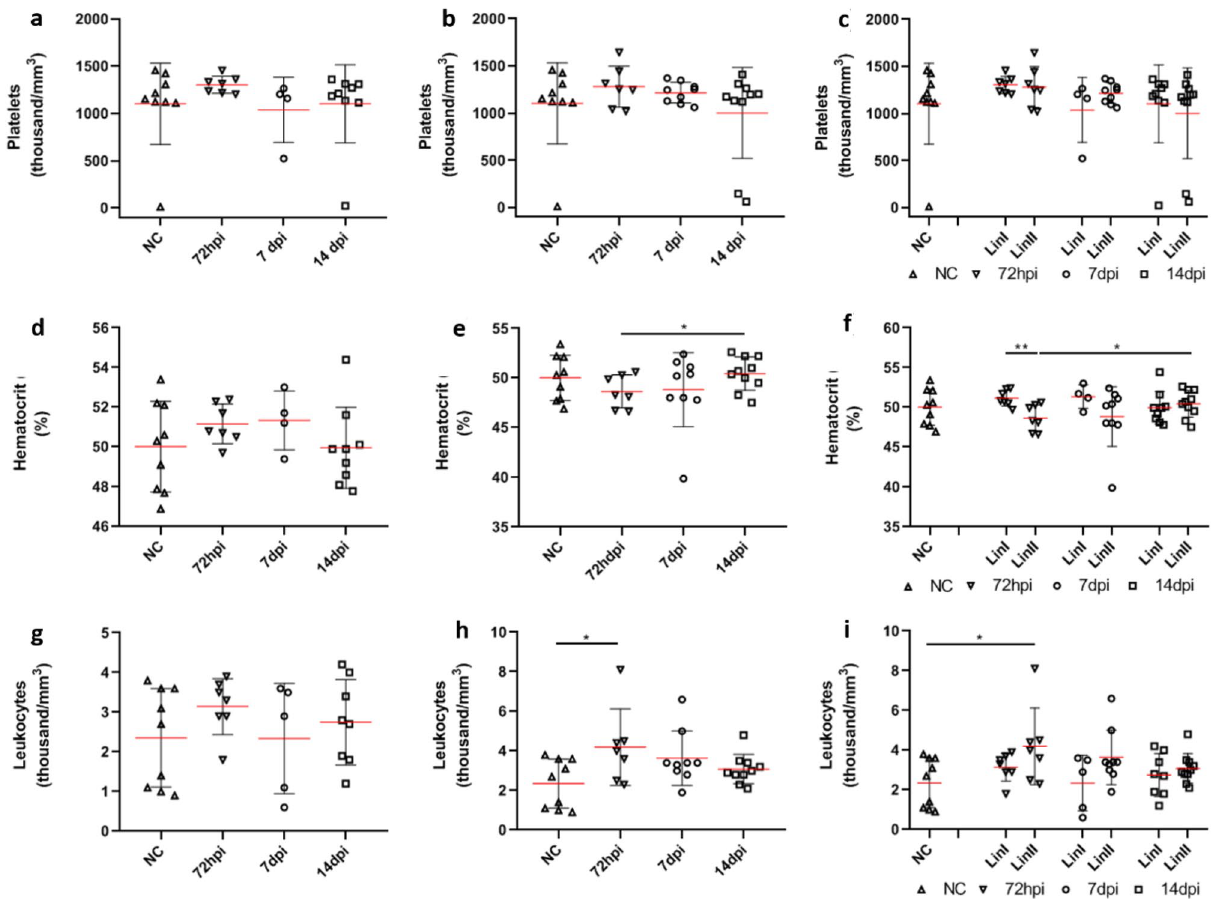
Figure 4. Hematological parameters of BALB/c mice uninfected and infected with DENV-2 Lineages 72 hpi, 7 and 14 dpi. Platelet count (thousands/mm 3 ): ( a ) DENV-2 Lineage I; ( b ) DENV-2 Lineage II; ( c ) comparison of platelet count means. Hematocrit (%): ( d ) DENV-2 Lineage I; ( e ) DENV-2 Lineage II; ( f ) comparison of hematocrit means. Leukocyte count (thousand/mm 3 ): ( g ) DENV-2 Lineage I; ( h ) DENV-2 Lineage II; ( i ) comparison of leukocyte count means. NC: (n = 10); Lin I: (n: 72 hpi = 10; 7dpi = 10; 14 dpi = 10); Lin II: (n: 72 hpi = 10; 7dpi = 10; 14 dpi = 10). NC: negative control, n: number of mice, hpi: hours post-infection, dpi: days post-infection, * p < 0.05, ** p <